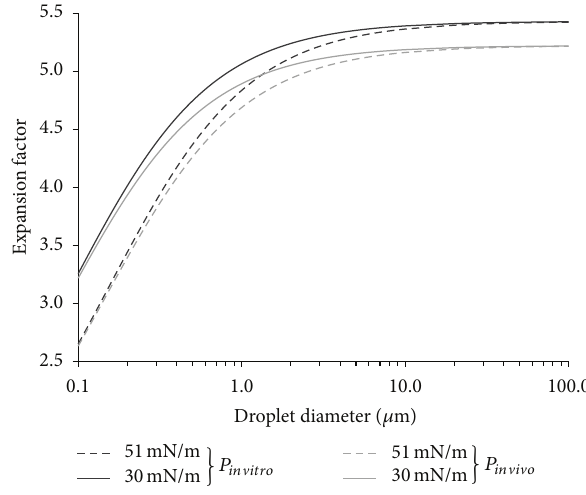
Figure 2: Effect of droplet size on expansion factor according to ideal gas laws with Laplace pressure included. Calculations are presented for two variations of both ambient pressure ( 𝑃 𝑖𝑛 V 𝑖𝑡𝑟𝑜 = + 𝑃 𝑃 ; 𝑃 𝑖𝑛 V 𝑖 V 𝑜 = 𝑃 ) and surface tension ( 𝜎 1 = 30 mN/m; 𝜎 2 = atm atm body 51 mN/m).Dropletsontheorderof10 𝜇 mcanbeexpectedtoexpand less in vivo than in vitro regardless of surface tension, while droplets of 500 nm or less will expand less at higher surface tension values. Reprinted from [50], Copyright 2011, with permission from